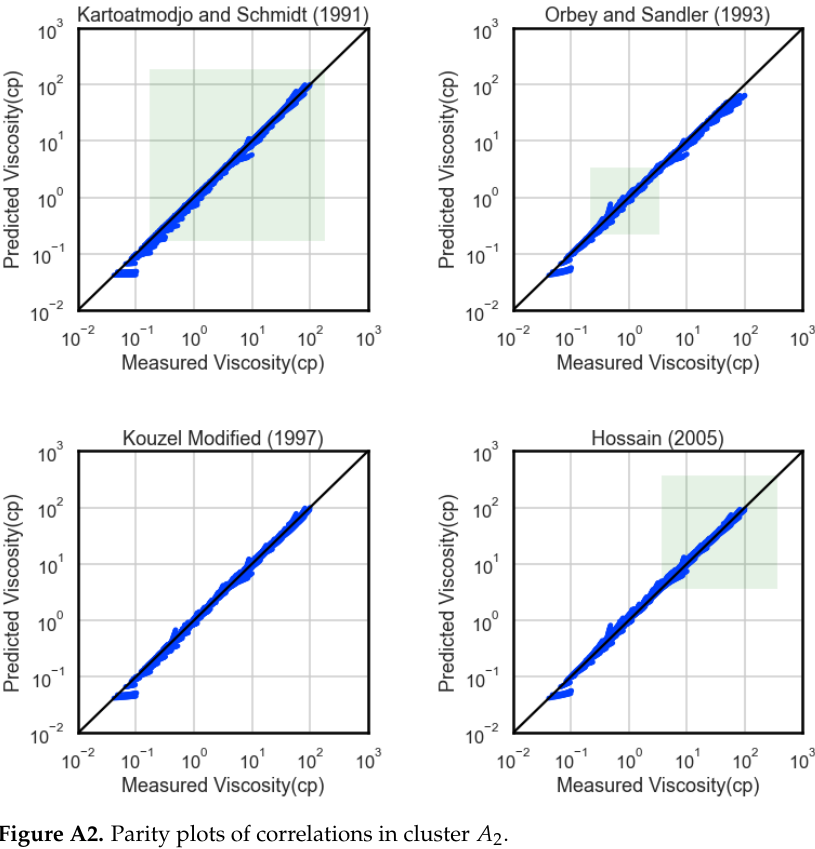
Figure A2. Parity plots of correlations in cluster A 2 .